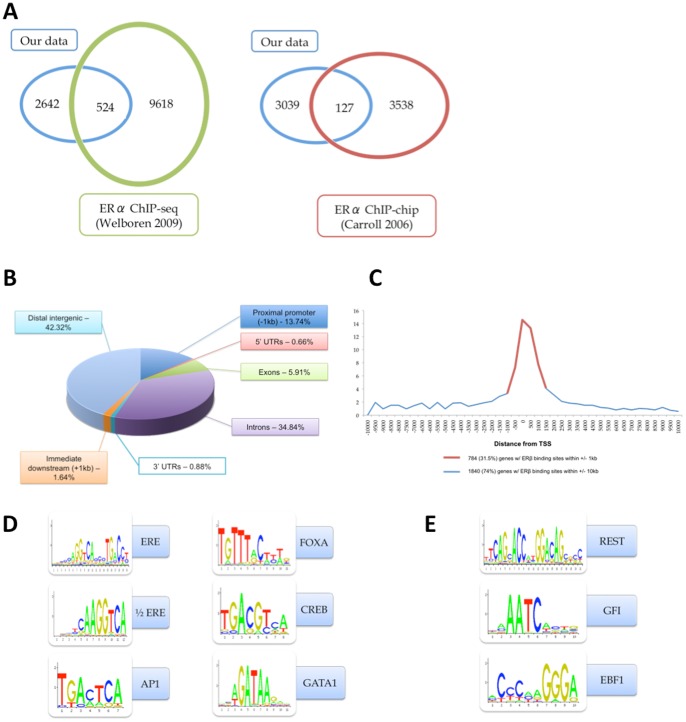
Overview of ERβ binding regions in C4–12/Flag.ERβ cells.ERβ binding sites identified in C4–12/Flag.ERβ cells (blue) were compared with ERα binding sites in MCF-7 cells (green and red). 524 sites are shared with the ERα landscape reported by Welboren 2009 [15]; 127 sites are shared with ERα landscape reported by Carroll 2006 [14]. (B) Global distribution of ERβ: less than 15% of ERβ binding sites were found in proximal promoter regions; most ERβ binding sites were found in introns and distal intergenic regions. (C) Density of ERβ binding sites around gene TSS. (D-E) ERβ binding sites were converted to 400-base long polynucleotides, centered at the binding summit. CLOVER motif analysis [36] was used to identify enrichment of transcription factor binding motifs in this library. JASPAR transcription factor binding motif database was used as the library of known motifs; CpG island, promoter regions and chromosome 20 were used for background analysis. (D) Enrichment of motifs known to associate with ER binding sites. (E) Enrichment of motifs unique to ERβ binding sites in C4–12/Flag.ERβ cells.